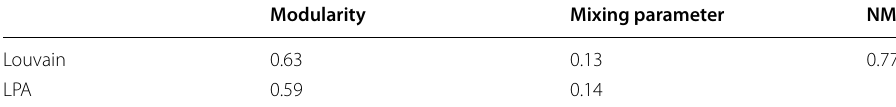
Table 2 Quality metrics of the community structures uncovered by Louvain and LPA community detection algorithms: modularity, mixing parameter, NMI